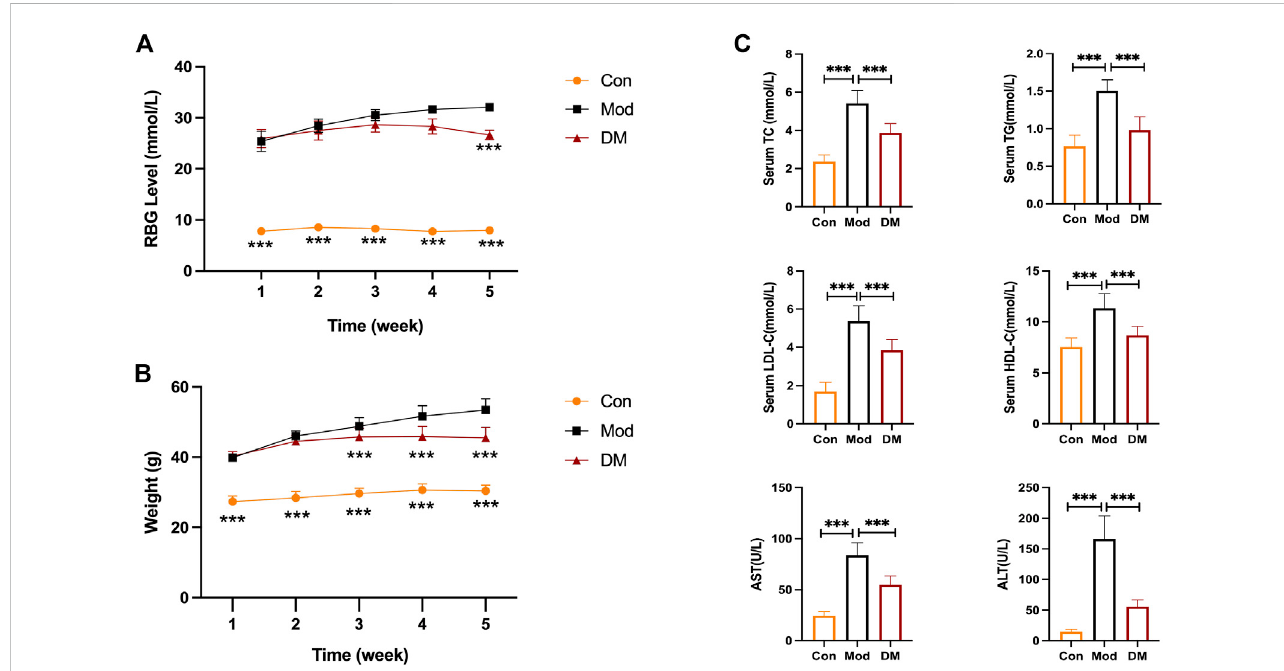
FIGURE 4 (A) DMreduced the elevated RBG level (mmol/L)in db/db mice ( n = 10 per group); (B) DM reduced thebody weight (g) in db/db mice ( n = 10 per group). ***p < 0.001 vs.Modasassessedbyone-wayANOVAwithTukey ’ smultiplecomparisontest; (C) TheserumlevelsofTC(mmol/L),TG(mmol/L),HDL-C(mmol/ L), LDL-C (mmol/L), AST (U/L) and ALT (U/L) I n the db/db mice ( n = 10 mice per group). ***p < 0.001 vs. Mod group as assessed by one-way ANOVA with Tukey ’ s multiple comparison test; Con: control group; Mod: model group; DM: DM treatment group.